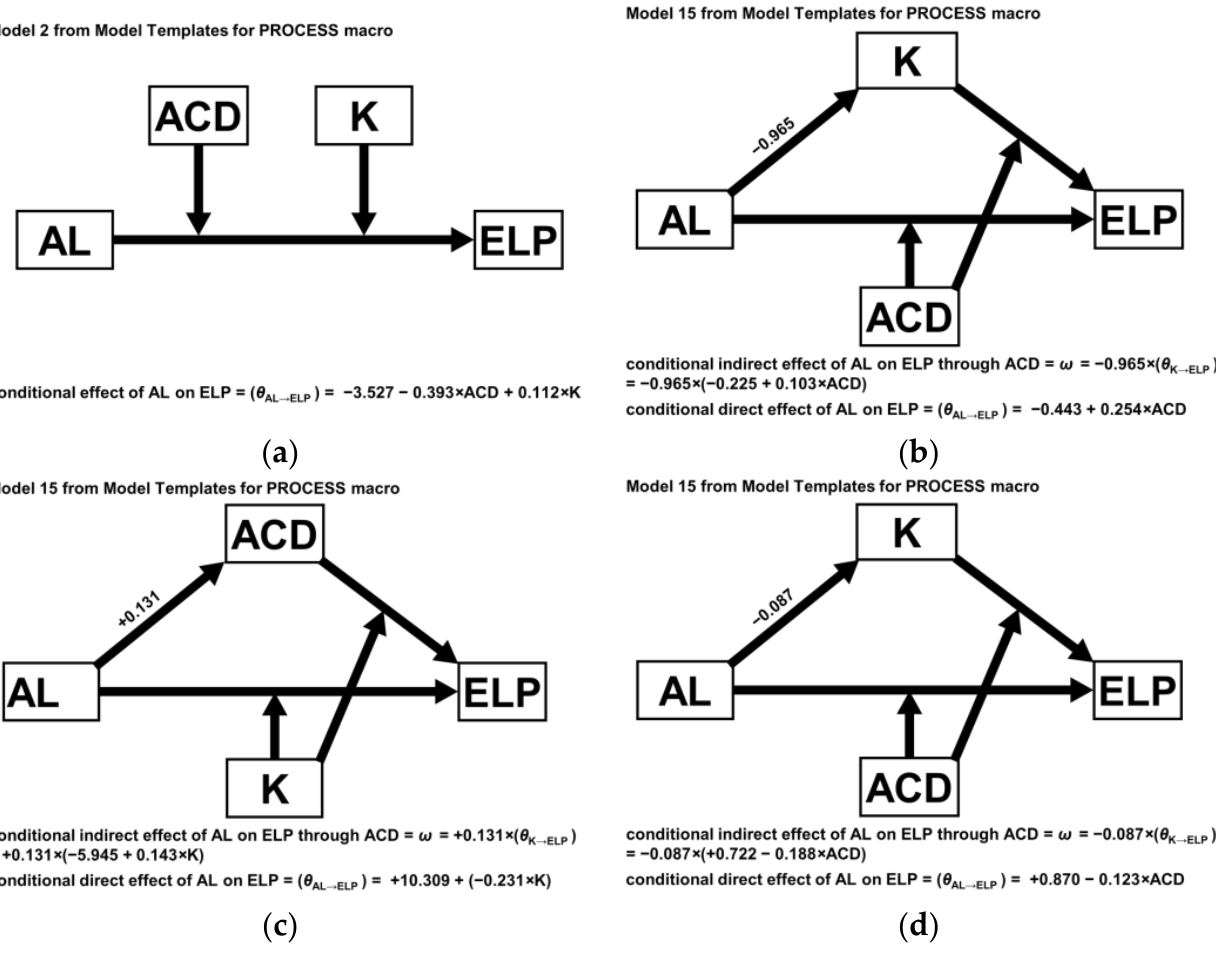
Figure 2. The structural equation models for the prediction of effective lens position (ELP) in each range of axial length (AL). ( a ) AL ≤ 23.0 mm; ( b ) 23.0 mm < AL ≤ 24.5 mm; ( c ) 24.5 mm < AL ≤ 26.0 mm; ( d ) AL > 26.0 mm. K = mean corneal dioptric power; ACD = anterior chamber depth. Table 4. Regression formulas for prediction of effective lens position according to preoperative axial